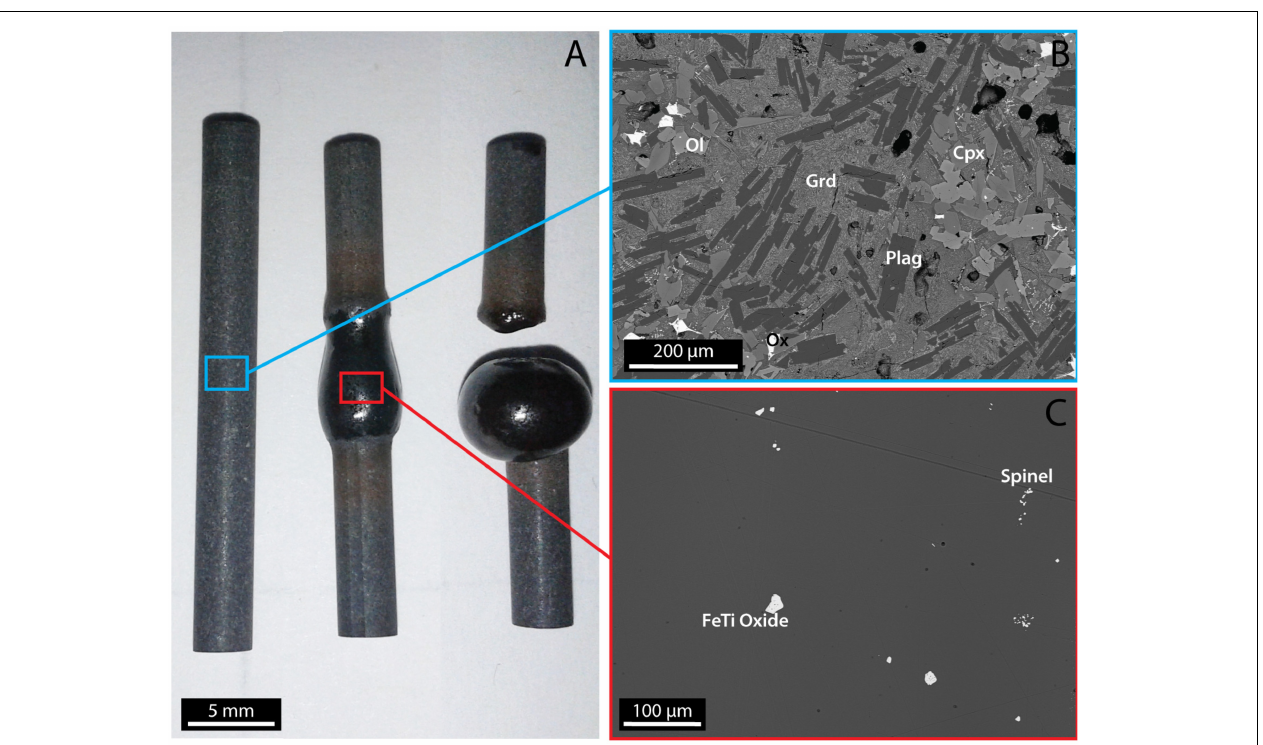
FIGURE 2 | (A) Cores of the Lovejoy basalt before (on the left) and after (in the middle) the melting phase at 1250 ◦ C. The core on the right is an example of a melt separating from the top part due to its lower viscosity at higher temperature. (B) SEM images of the Lovejoy basalt before the melting phase. (C) SEM images of the Lovejoy basalt showing the structure of the zone melted at 1250 ◦ C. Cpx: clinopyroxene; Grd: groundmass; Plag: plagioclase; Ol: